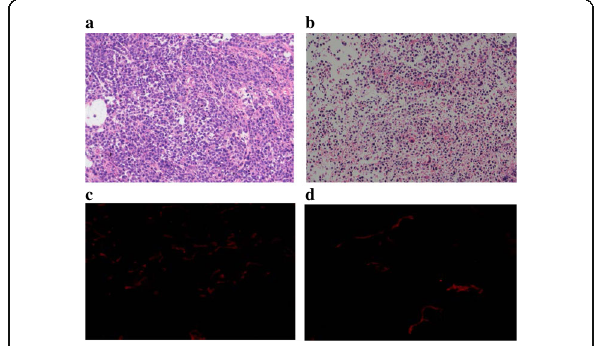
Fig. 14 Tumour tissue section HE staining and CD31 fluorescent staining. a control group (HE); b oridonin group (HE); c control group (CD31); d oridonin group (CD31)